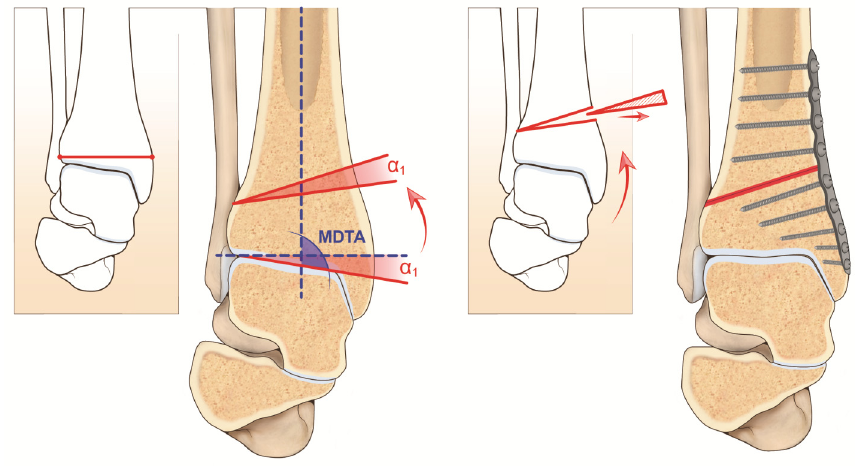
Figure 1. Visual artwork showing α angle of correction and MDTA (medial distal tibial angle). α : angular correction desired.